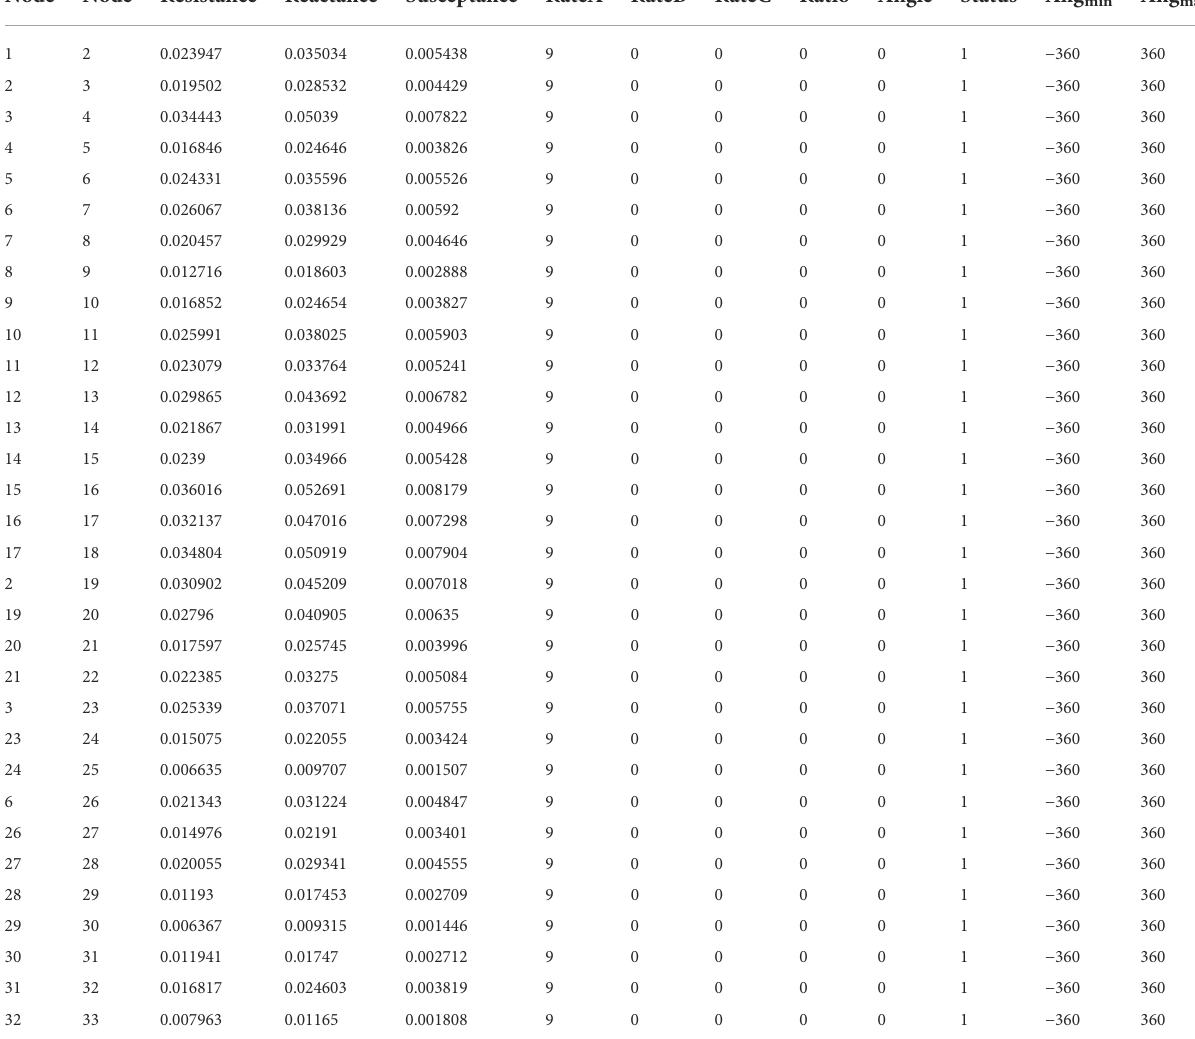
TABLE 3 Parameters of the IEEE-33 node